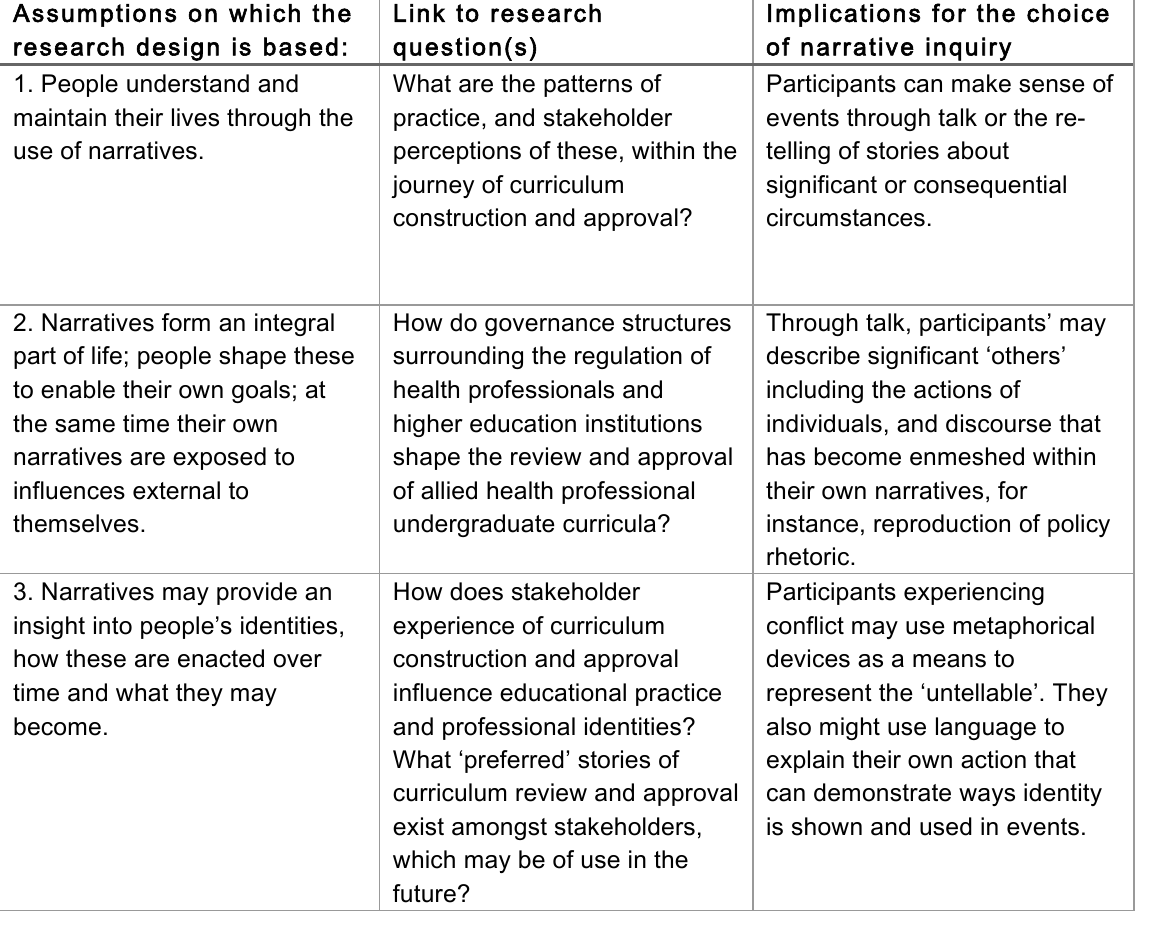
Table 1: The Link between assumptions about narrative research and design of this inquiry Assumptions on which the Link to research design is based: